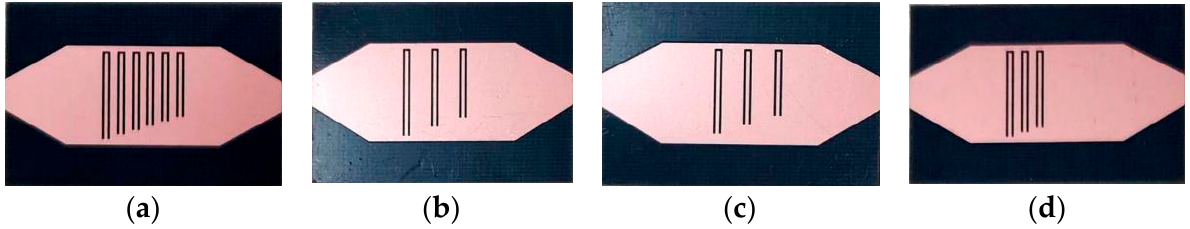
Figure 10. Picture of U-shaped slot resonator chipless tags: ( a ) ID111111; ( b ) ID101010; ( c ) ID 010101; ( d ) ID 111000.